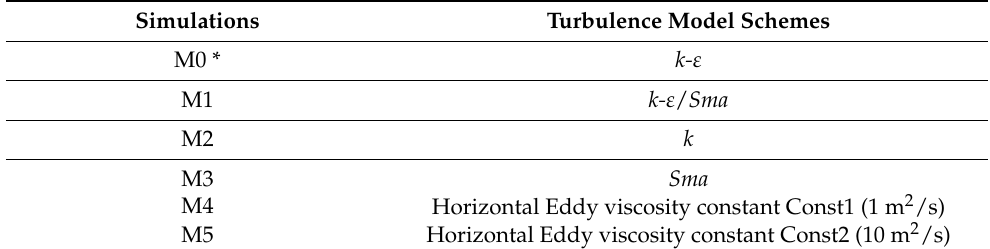
Table 3. The simulation description for the turbulence model schemes.